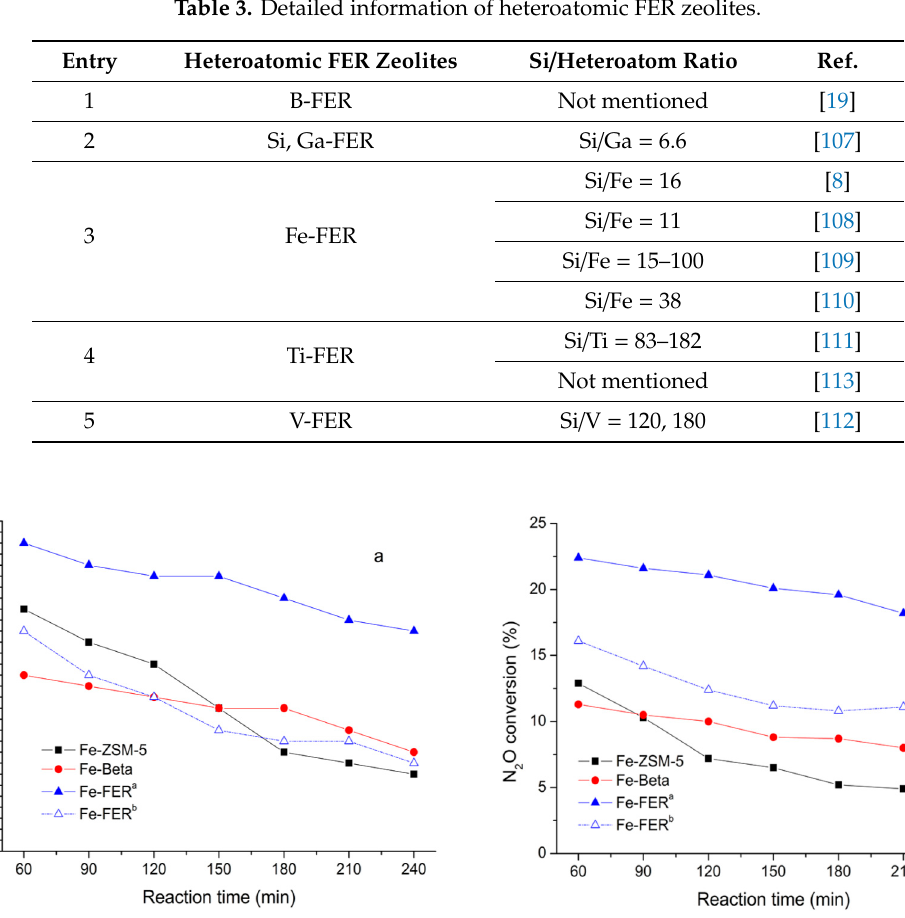
Table 3. Detailed information of heteroatomic FER zeolites.